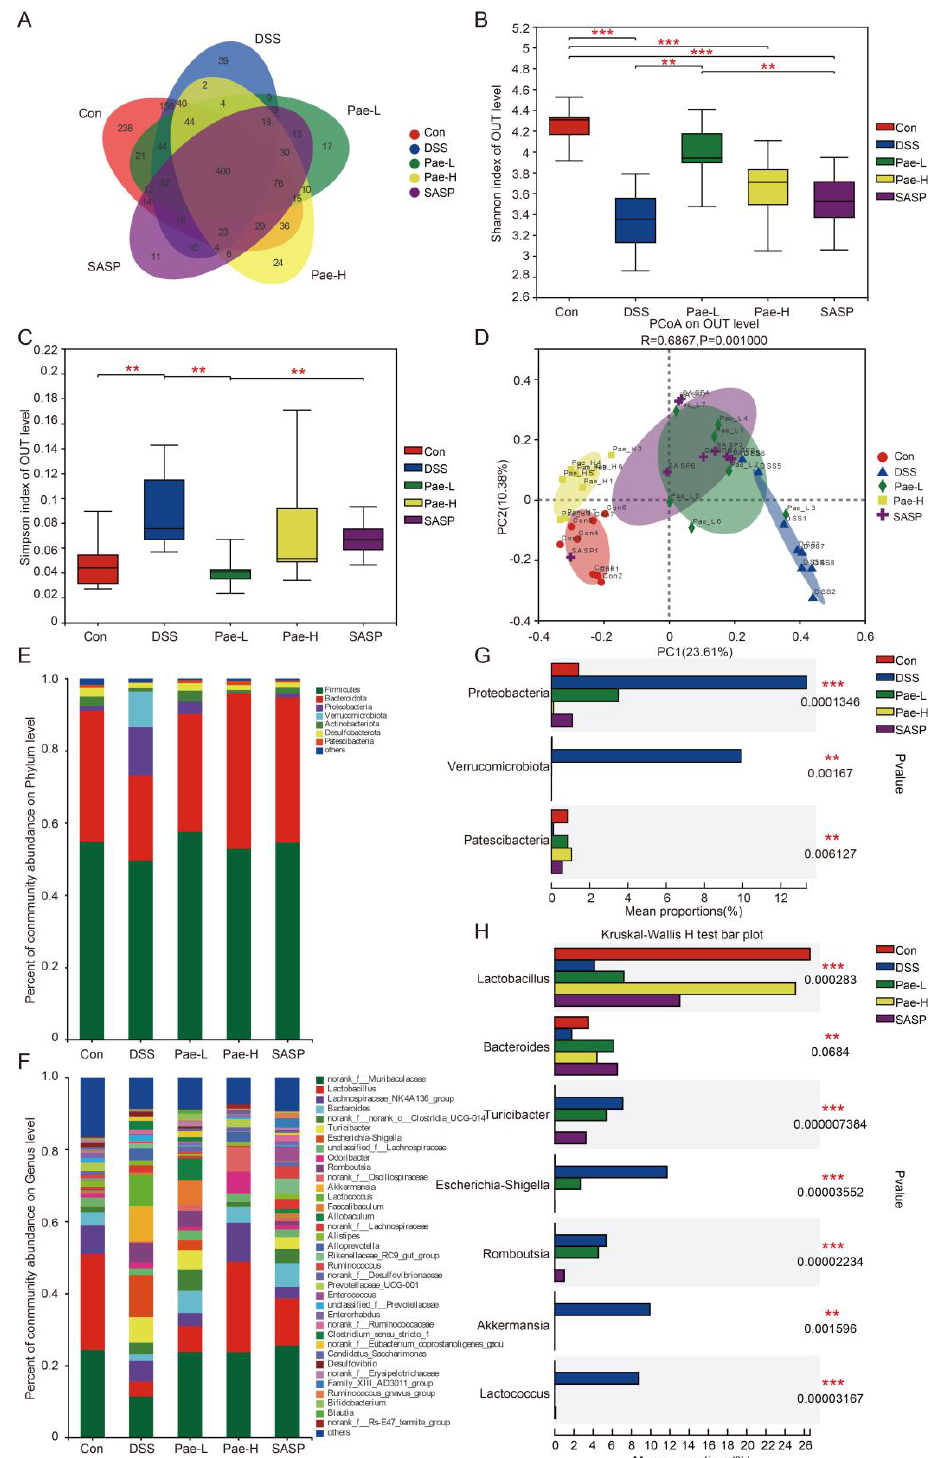
Figure 4. Effects of Pae on the fecal gut microbiota alterations in DSS-induced UC mice. ( A ) Venn diagram showing common species comparison with the five groups. ( B ) The Shannon index of the gut microbiota. ( C ) The Simpson index of the gut microbiota. ( D ) Multiple sample PCoA of the Bray-Curtis distance based on OTUs. ( E ) Microbial community bar plot at phylum level. ( F ) Relative abundance of the gut microbiota at the genus level. ( G , H ) Relative abundance of the significantly altered bacteria at the family and genus levels from the five groups. Data are presented as the mean ± sem. n = 7 or 8. ** p < 0.01; *** p <